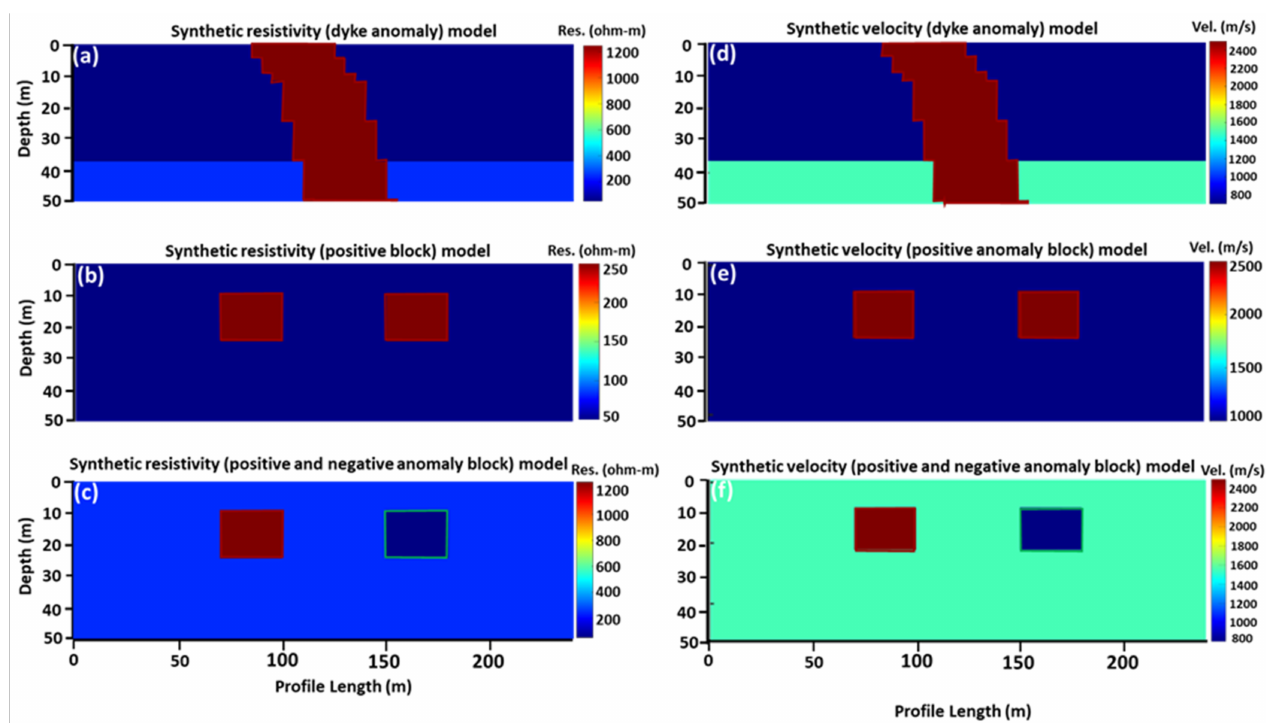
Figure 3. Synthetic models for ( a ) resistivity (dyke anomaly) model, ( b ) resistivity (positive anomaly) model, ( c ) resistivity (positive and negative anomalies) model, ( d ) velocity (dyke anomaly) model, ( e ) velocity (positive anomaly) model, and ( f ) velocity (positive and negative anomalies) model. The dark red and green lines are used to mark the anomaly